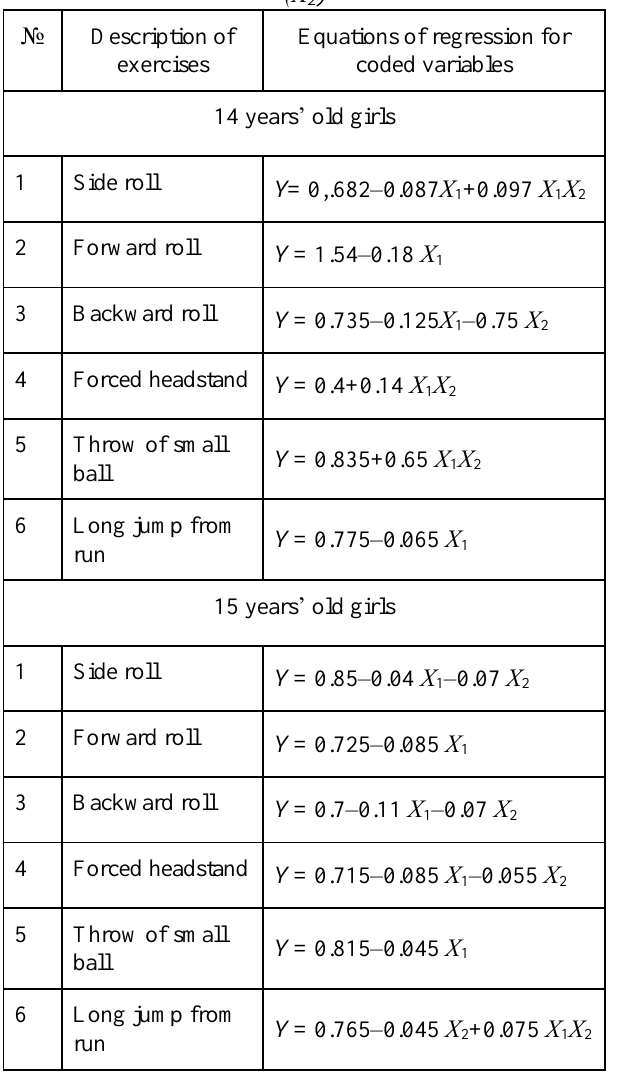
Regressive dependence of results in 14-15 years’ old girls’ training on quantity of repetitions (Х 1 ) and rest